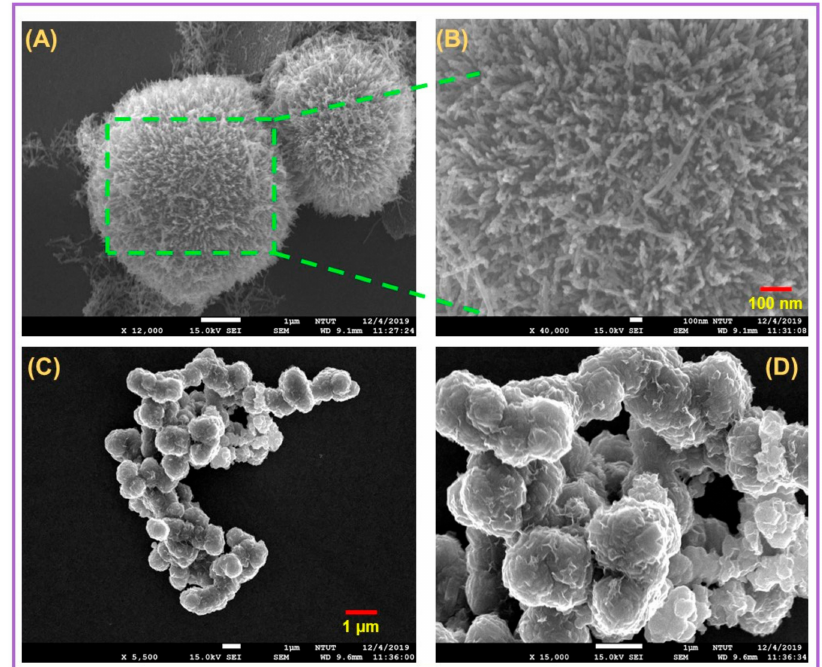
Figure 1. ( A ) FE-SEM of NiCo 2 O 4 -MFs, ( B ) magnified image of NiCo 2 O 4 -MFs and ( C , D ) NiCo 2 S 4 -Ms. Scale bar 100 nm.